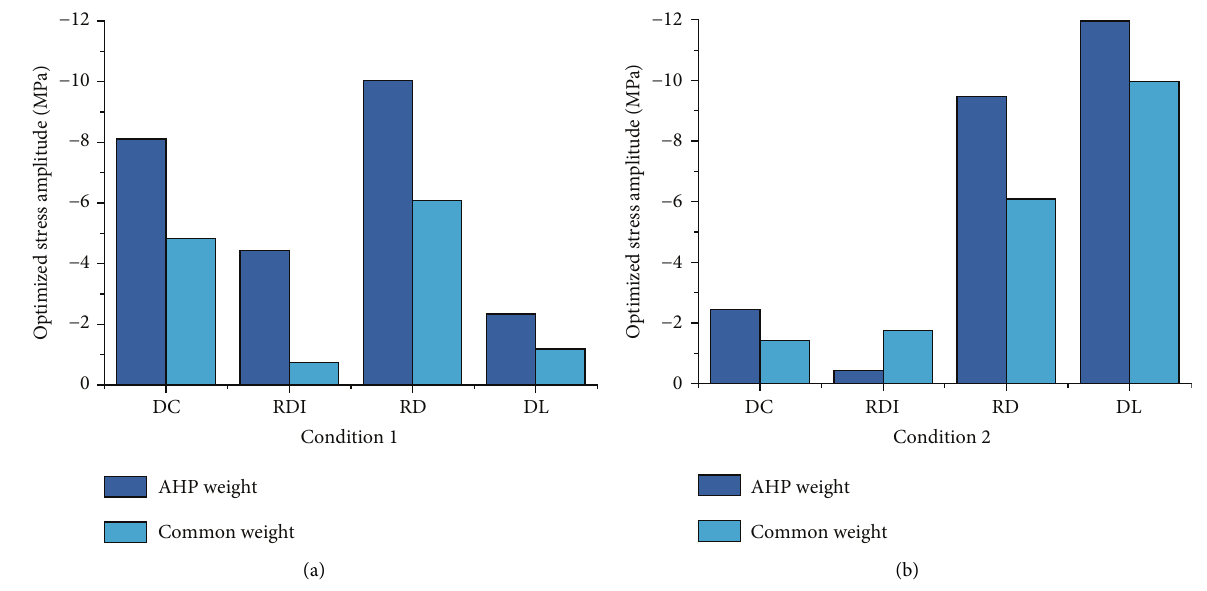
Figure 17: Optimized stress amplitudes of two different weight